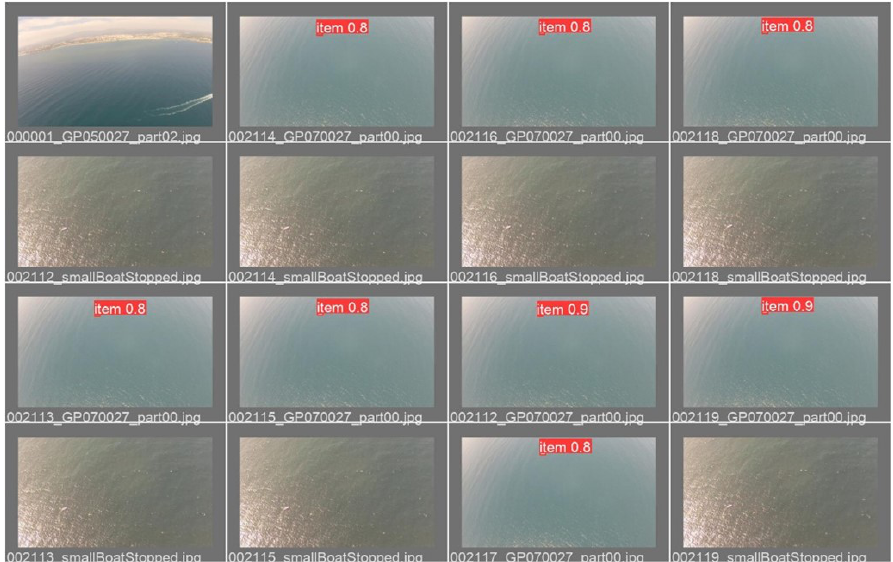
Figure 12. Examples of annotated images from the SEAGULL test set—predicted bounding boxes with the confidence visible as drawn by the algorithm trained on SEAGULL